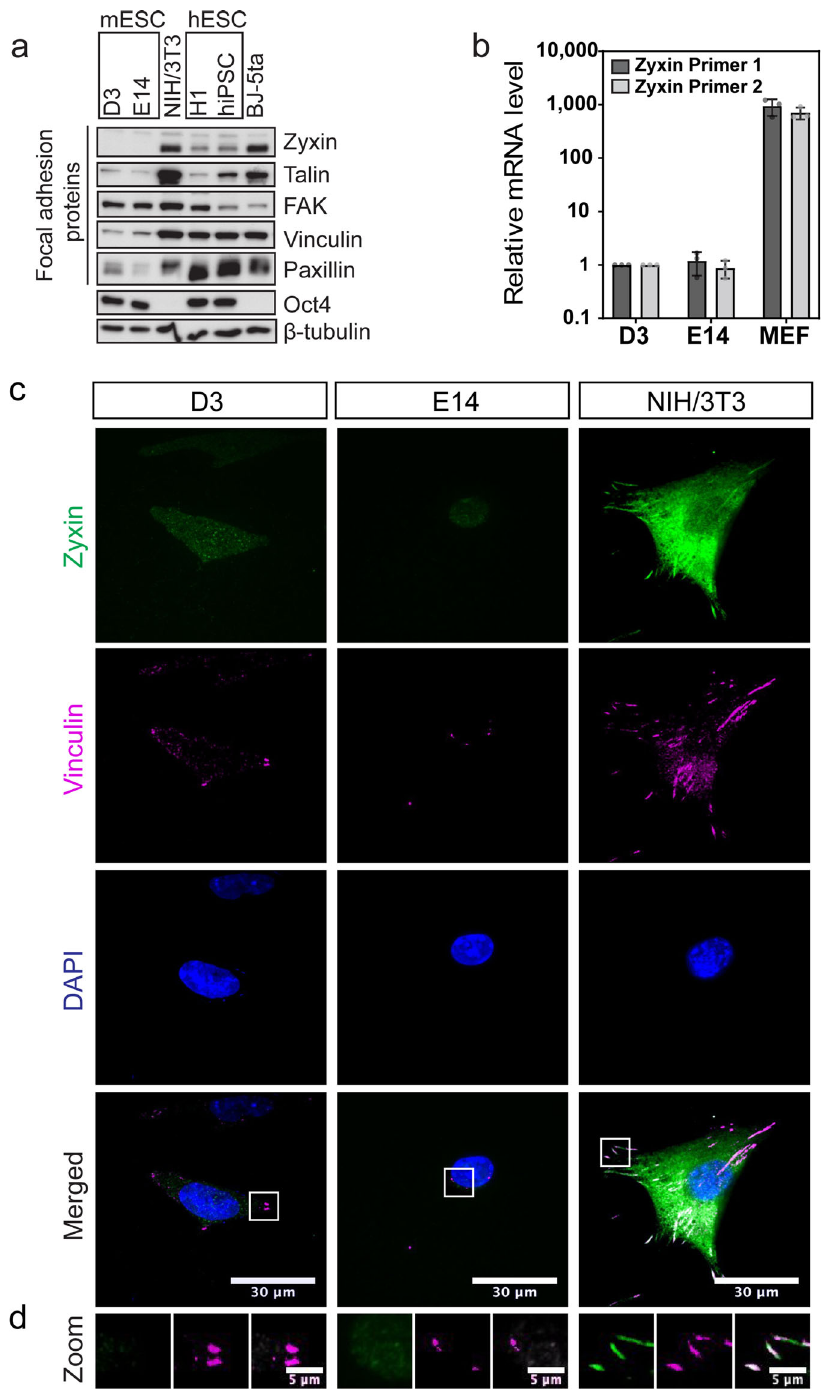
Fig. 2 Zyxin is lowly expressed in both mESC and hESC. a A panel of focal adhesion proteins were examined in mESC, hESC, mouse fi broblasts (NIH/3T3) and human fi broblasts (BJ-5ta). Oct4 was used to indicate pluripotency and β -tubulin was used as loading control. b Zyxin expression at mRNA level was monitored using two independent zyxin primer sets ( N = 3). Relative quanti fi cation values were normalized against β -tubulin and presented as fold change with D3 as internal control. Error bars represent standard deviations. c Zyxin localization at focal adhesion was monitored by immuno fl uorescence, using antibody against zyxin. Vinculin was used as a marker for focal adhesion. d Focal adhesions at the cell periphery (boxed region in c ) were zoomed in and shown here. Z-stacked images with maximum intensity projection were shown. Representative images from three biological repeats were shown. Scale bar: 30 μ m for original images, 5 μ m for zoomed in